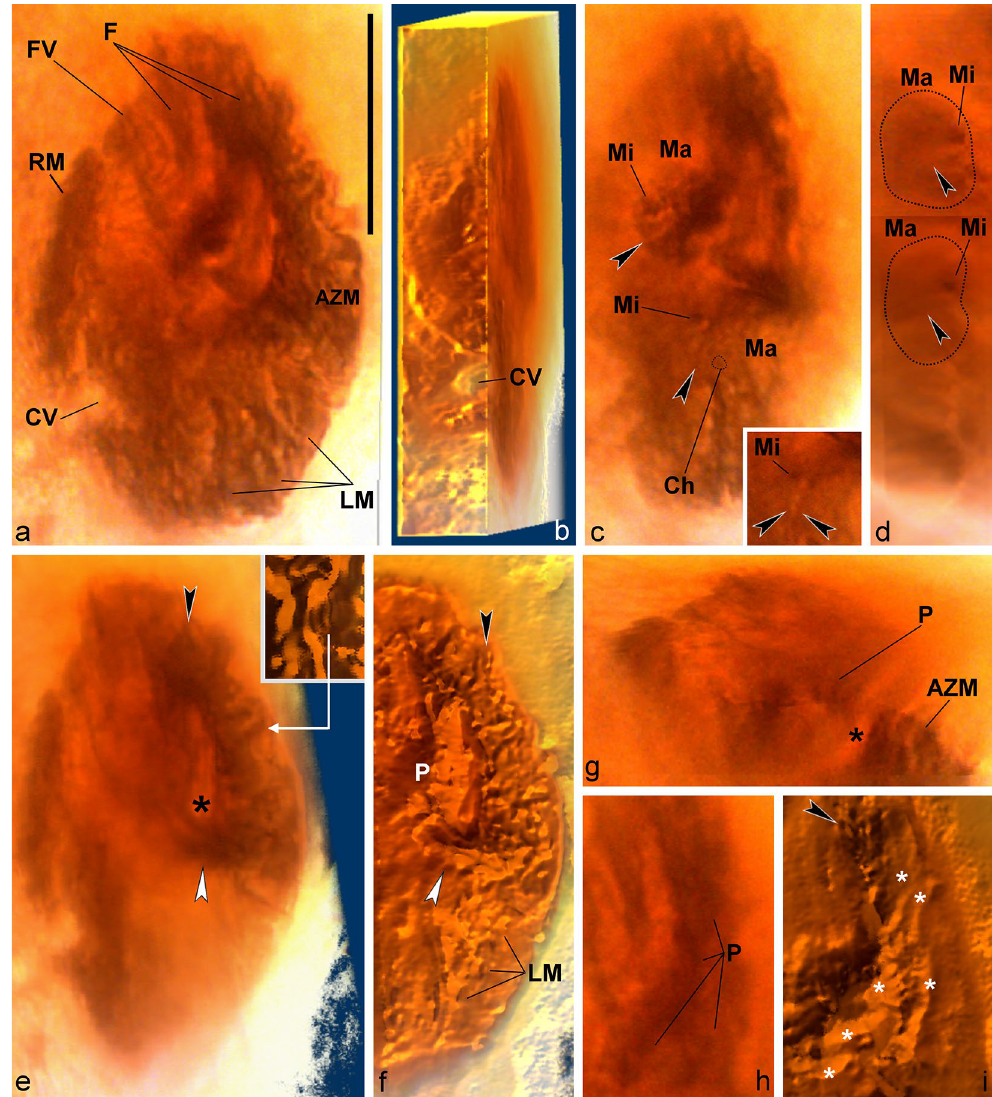
Figure 2. Light microscopy photographs ( a , c , h ) and volumetric reconstructions ( b , d , e–g , i ) of Palaeohypothrix bahiensis gen. et sp. nov. holotype. ( a ) Z-stack of photographs to compose the entire ventral surface. Ventral side. ( b ) Right side to show presumed contractile vacuole. ( c , d ) Detail of nuclear apparatus; bottom right inset in c. to show slightly different focal plane. ( c ) Ventral view. ( d ) Right lateral view assembled from two longitudinal sections to show both macronuclear nodules, circumscribed by dotted line. ( e ) Ventrolateral view to show the adoral zone of membranelles; figure inset shows detail of one lapel membranelle. Asterisk marks oral cavity; black and white arrowheads point to distal and proximal ends of lapel adoral zone, respectively (same in f ). ( f ) A ventral focal plane under simulated oblique illumination. ( g ) Transversal section showing oral cavity (asterisk). ( h , i ) Detail of paroral. ( h ) Bright field photograph. ( i ) Simulated oblique illumination. Arrowhead shows insertion pits of frontal brushes; asterisks mark ciliary brushes which compose the paroral. Legends: AZM adoral zone of membranelles, Ch vestige of chromatin condensation, CV contractile vacuole, F frontal ciliary structures, FV fronto-ventral ciliary structures, LM left marginal ciliature, Ma macronuclear nodule, Mi micronucleus, P paroral membrane, RM right marginal ciliature. Scale bar = 20